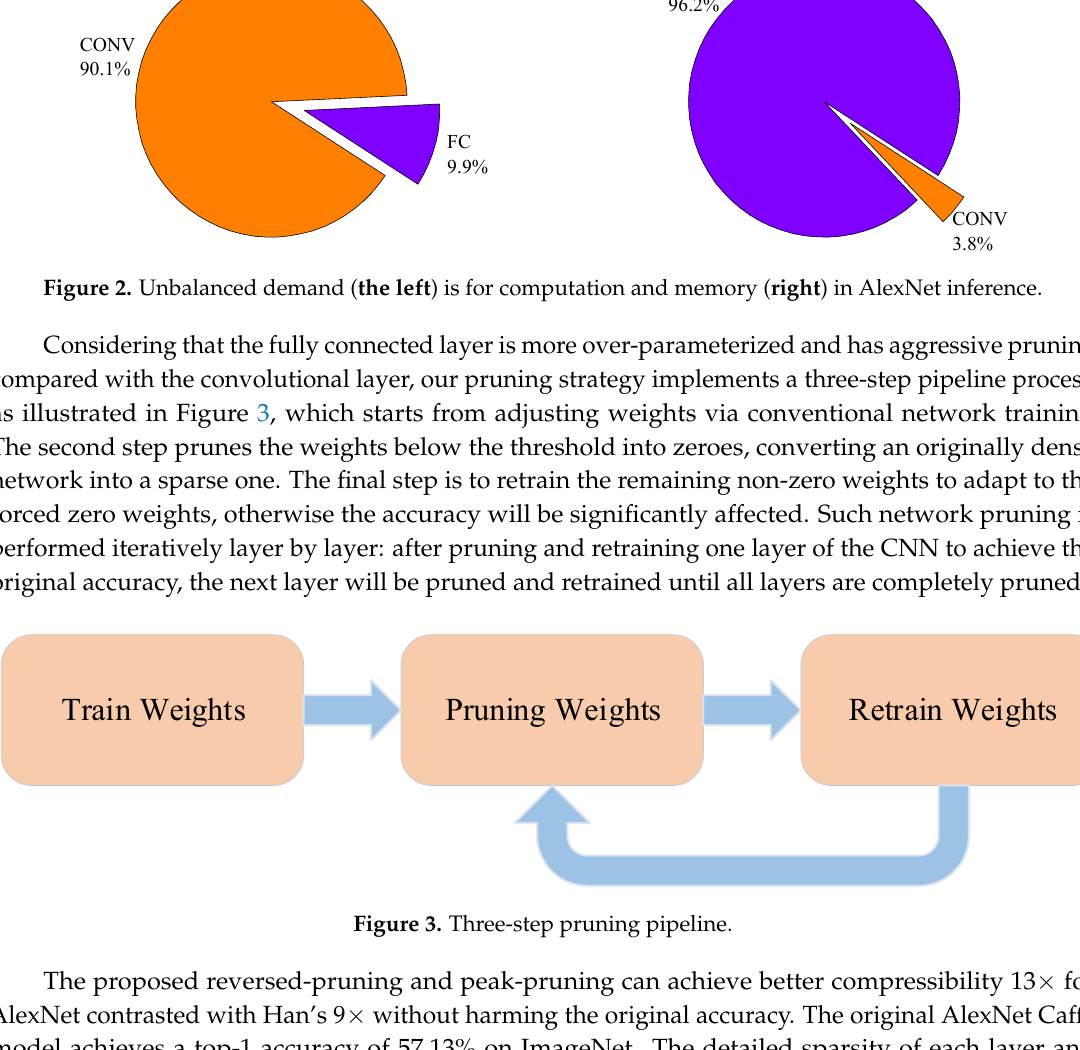
Figure 3. Three-step pruning pipeline.